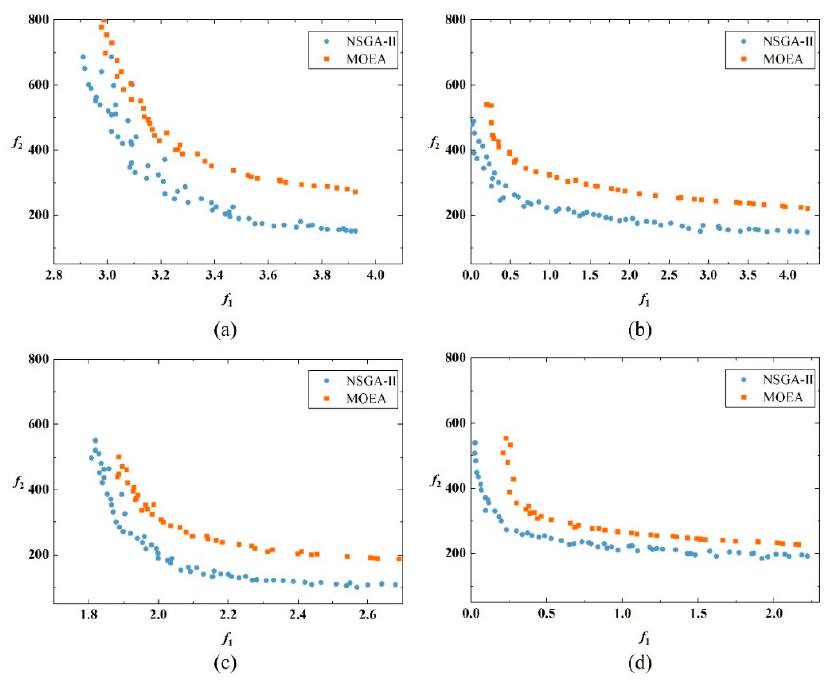
Figure 4. Nondominated fronts constructed by NSGA-II and MOEA for the corresponding conditions: ( a ) TWC in wet condition; ( b ) EPP in wet condition; ( c ) TWC in dry condition; ( d ) EPP in dry condition ( f 1 : equity, f 2 : cost).